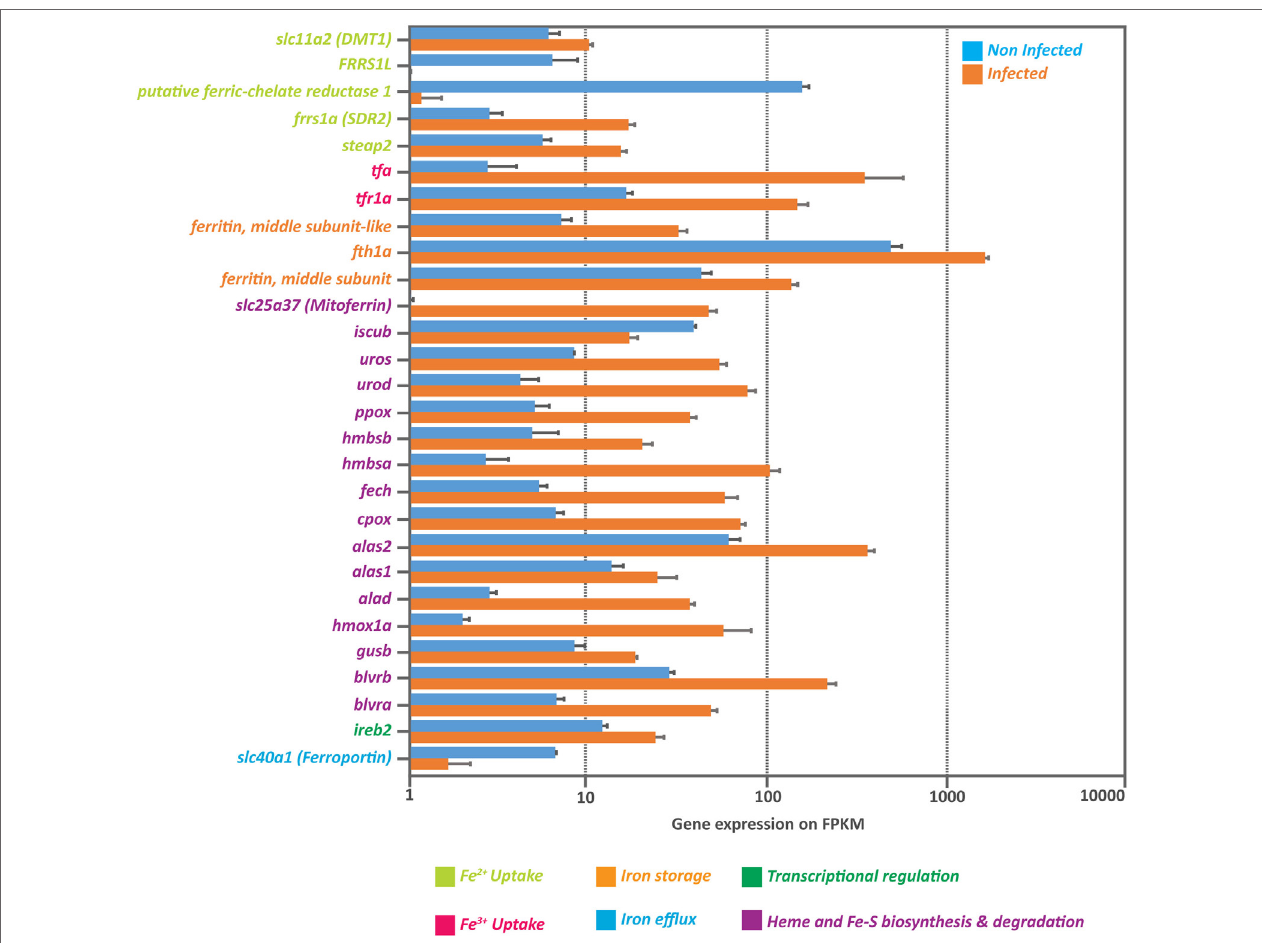
FigUre 6 | Massive upregulation of genes involved in iron intracellular availability. Expression of genes associated to iron uptake, storage, heme synthesis and degradation as well as transcriptional regulation, obtained from the RNA-seq data from infected and non-infected headkidney (normalized expression in Fragments Per Kilobase per Million reads or